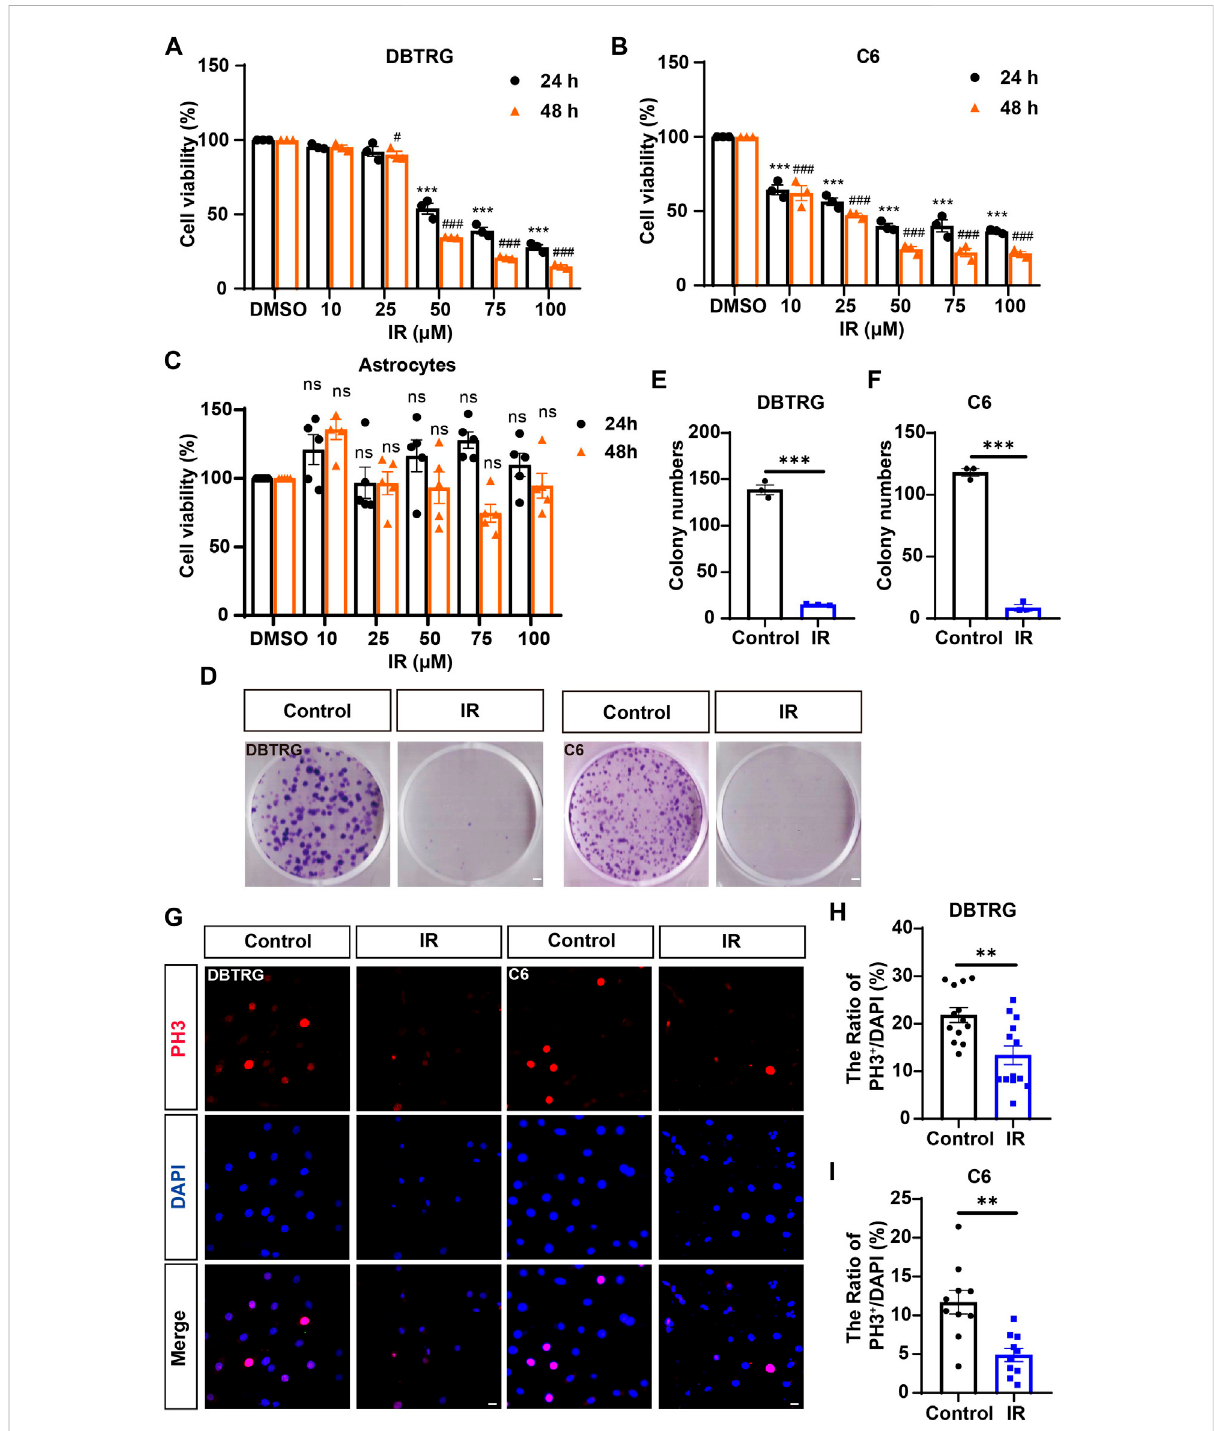
FIGURE 1 Irigenin inhibited the proliferation of GBM cells. (A – C) The IC 50 of irigenin (IR) was measured by CCK-8 in DBTRG cells (A) , C6 cells (B) and astrocytes (C) ( n = 3, per group, normalized to the control group). The DBTRG cells, C6 cells and astrocytes were seeded in 96-well plates at 4×10 3 / well and treated with different concentrations (0, 10, 25, 50, 75, 100 μ M) for 24 h or 48 h for CCK-8 assay. (D) The Colony formation assay showed the anti-proliferative activity of 50 μ M IR in DBTRG and C6 cells. (E – F) Quanti fi cation of the clone numbers in DBTRG cells (D) and C6 cells (E) , as shown in (C) ( n = 3, per group). (G) Immuno fl uorescent staining of PH3 (red) in DBTRG and C6 cells treated with 40 μ M IR for 24 h (H – I) Quantitativeanalysis ofthepercentageofPH3 + cellsovertotalDBTRGcells (H) andC6cells (I) inone fi eldshownin (G) ( n =13,pergroup).Scalebar, 2 mm in fi gure (D) and 20 μ m in fi gure (G) . Data were shown mean ± SEM. * p < 0.05 , * *p < 0.01 , *** p < 0.001 , compared with control group. # p < 0.05 , ### p < 0.001 , compared with 48 h control